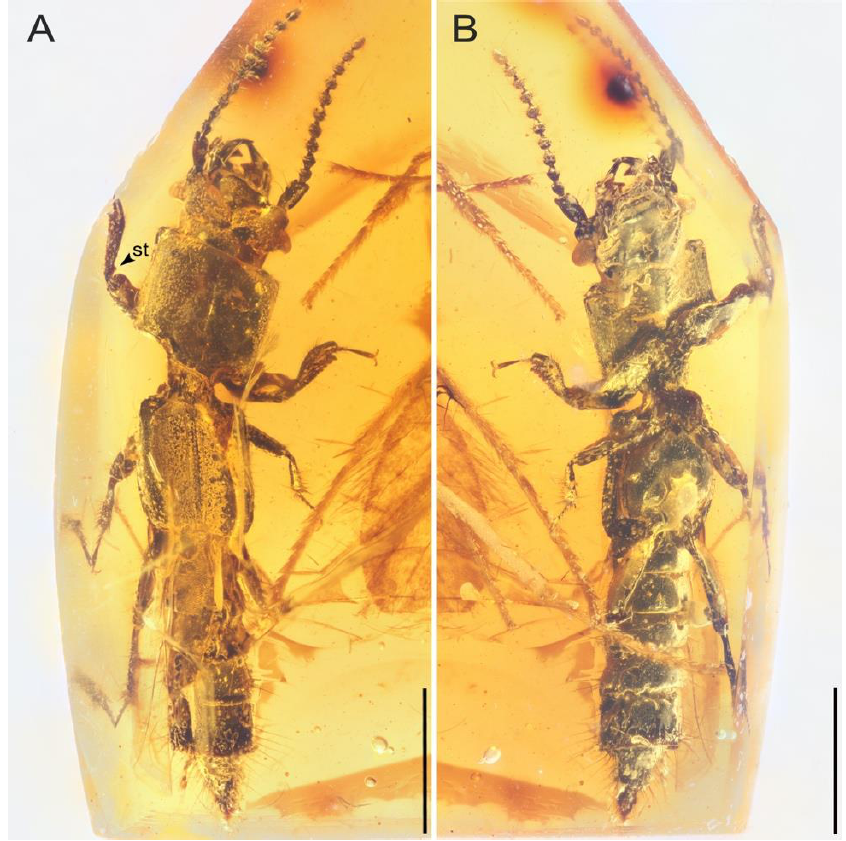
Figure 1. Priochirus trisclerite sp. nov., holotype, QUST-SHUO-0003. ( A ) Dorsal habitus. ( B ) Ventral habitus. Abbreviations: st, subtriangular teeth. Scale bars = 1 mm.